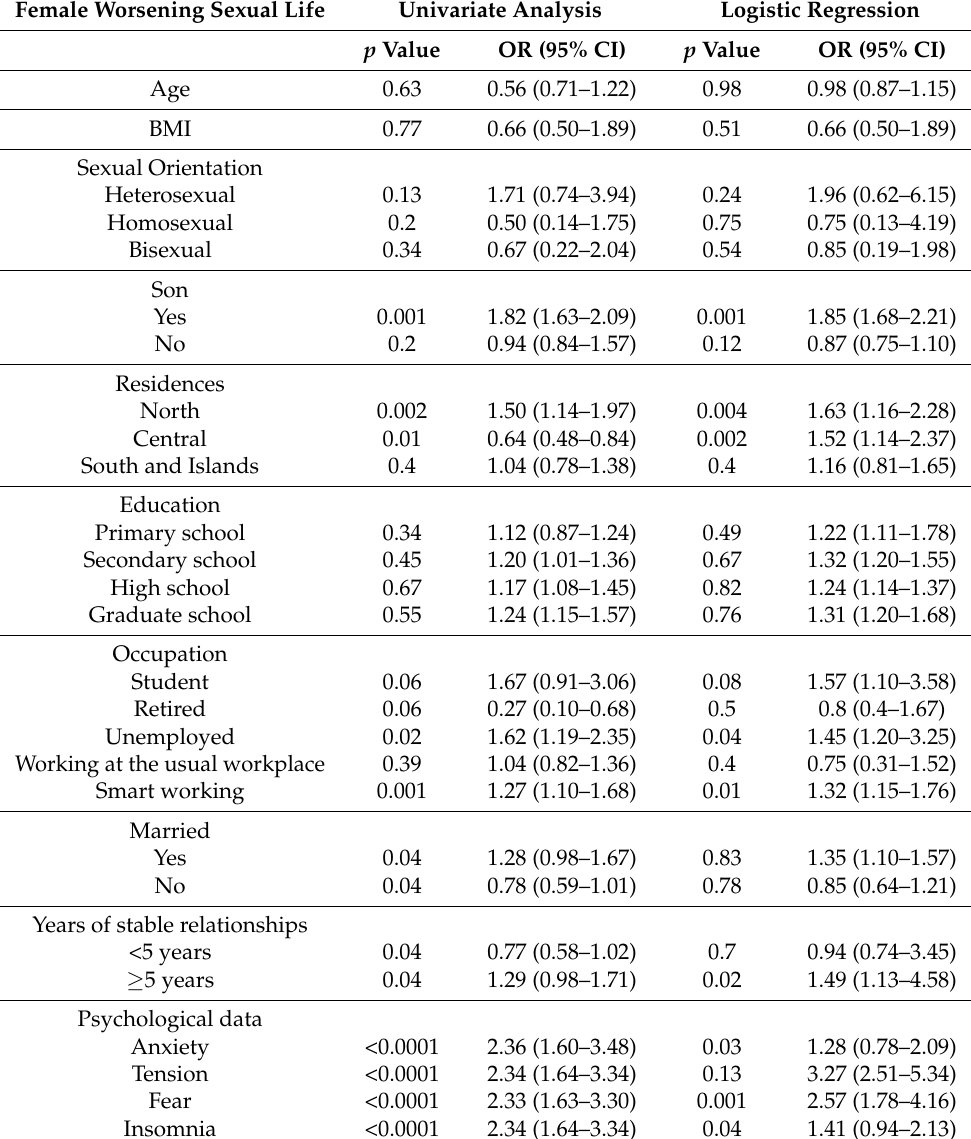
Table 5. Univariate analysis and multivariate logistic regression final model for female worsening sex lives vs. demographic and psychological data.